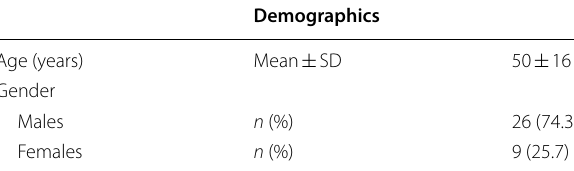
Table 1 Demographic characteristics of the studied